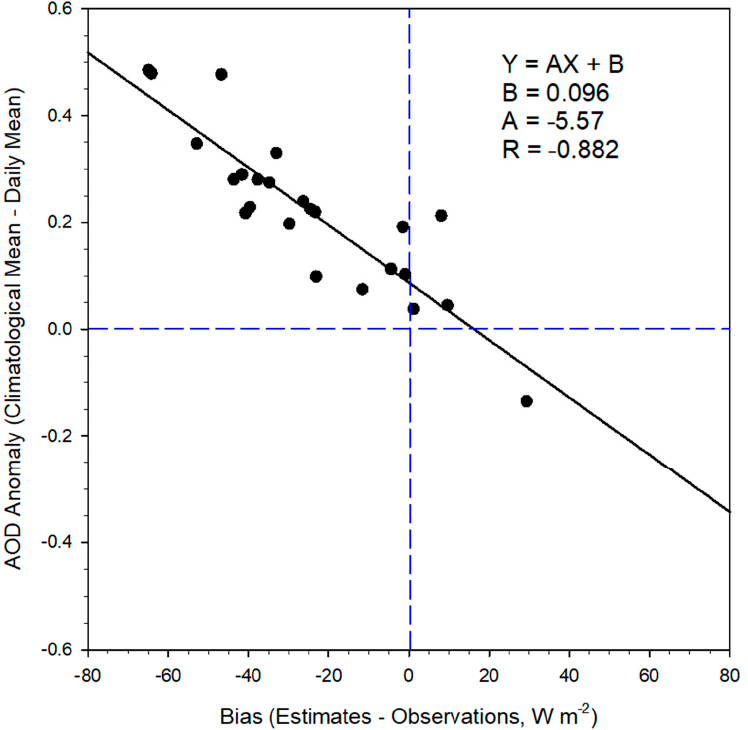
Figure 7. Scatter plot of bias between global horizontal irradiance (GHI) estimates from the control run and ground observations at the Korea Institute of Energy Research (KIER) station and aerosol optical depth anomaly. Pearson correlation coefficient, slope, and intercept of the linear regression are presented in the index of the graph.